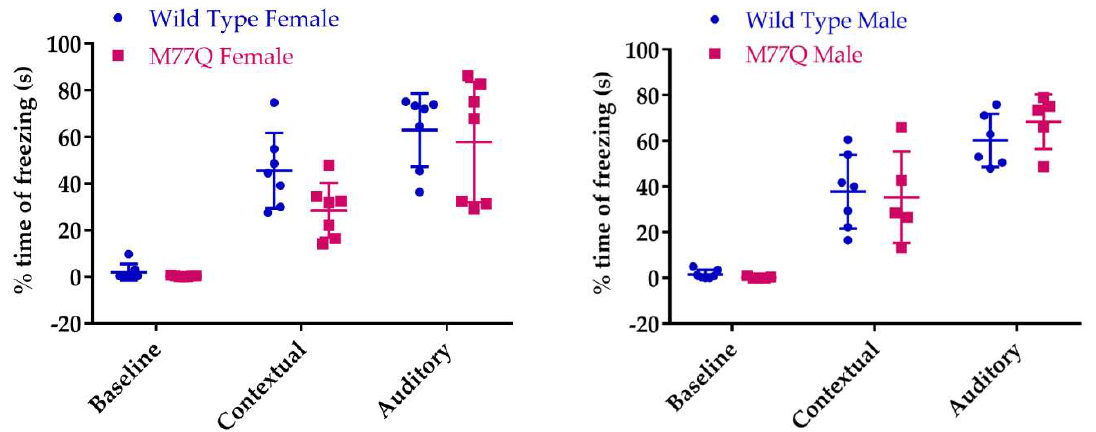
Figure 11. Fraction of time in which the mice freeze during the associative conditioning test. We tested 7 wild type and 5 M77Q males and 7 wild type and 7 M77Q females.